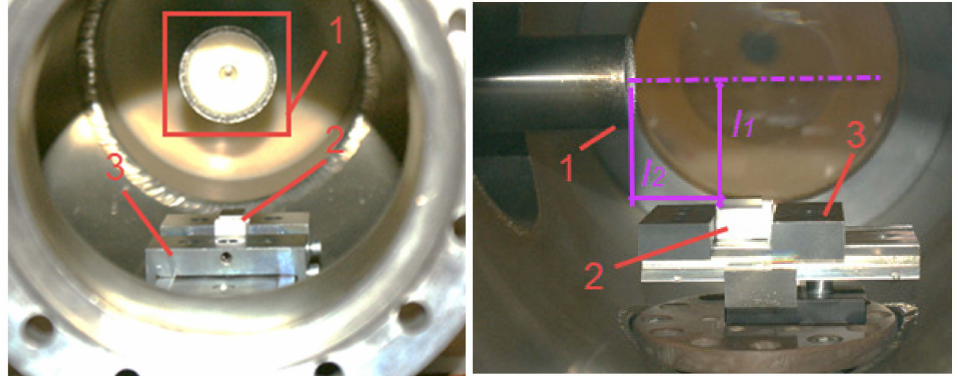
Figure 1. Scheme of sample (with Mo/Si coating) placement: 1–coaxial electrode unit, 2–sample and 3–sample